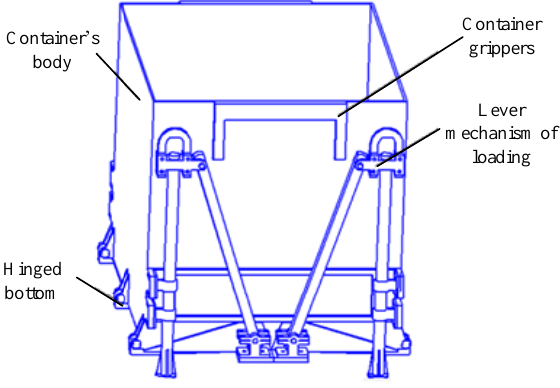
Fig. 5. Container pattern.